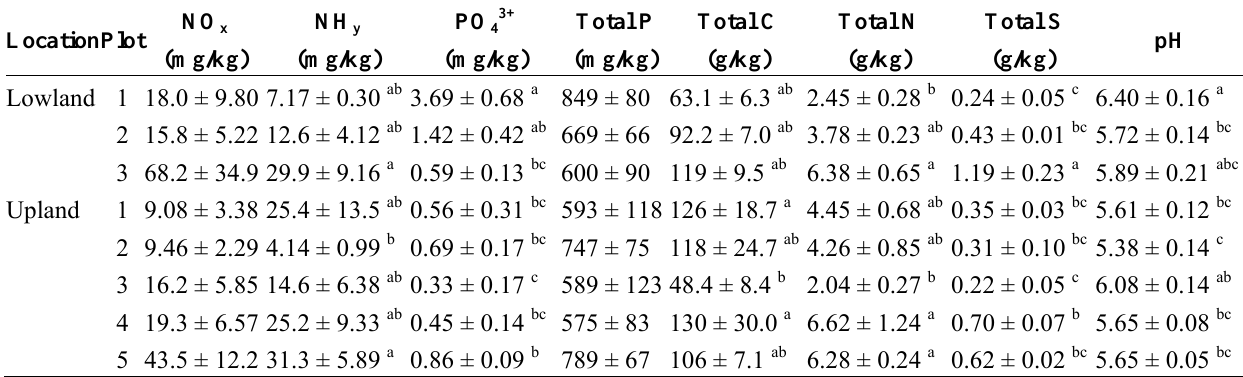
Table 9. Soil characteristics of old-growth forest plots in Central Kamchatka, means ± SE. Superscript letters denote significant differences between plots where detected (Tukey’s HSD; see text for